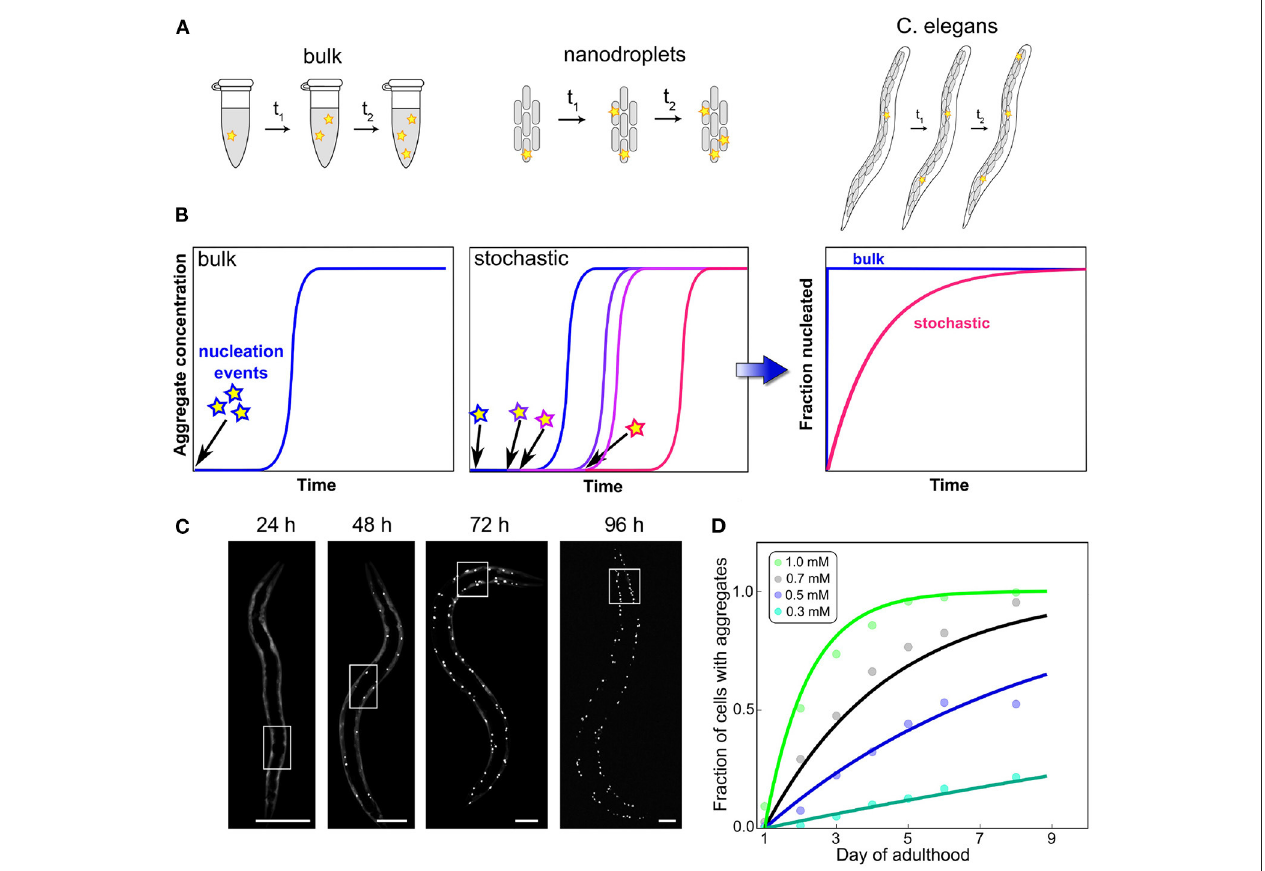
FIGURE 4 | Confinement and determination of the kinetics by a stochastic nucleation event. In bulk, many initiation events take place in a short amount of time, compared to the overall timescale of the reaction (A) . This leads to reproducible curves (B) and can often mean that little information about the initiation process can be obtained from an analysis of the data because they are dominated by other processes. By contrast, when the same reaction is carried out in volumes so small that initiation is rare on the timescale of the aggregation reaction, stochastic behavior emerges. Each experimental curve is governed not only by the rate constants of aggregation but also by when the random event of nucleus formation occurred. This effect can also be observed in the aggregation of polyQ in C. elegans worms (scale bars 50 µ m), where each cell behaves like an independent reaction vessel (C) . By globally fitting how the fraction of aggregated cells varies over time for different polyQ concentrations, the reaction order of the initiation process can be determined (D) . Adapted from Sinnige et al.